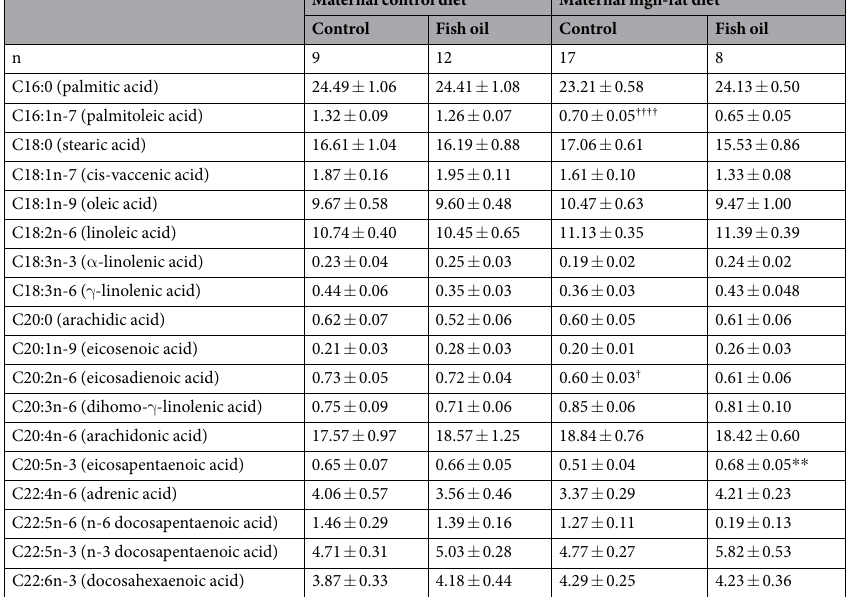
Table 6. Concentrations of polyunsaturated fatty acids in liver phospholipids of rat pups culled at day 2, according to the maternal diet (control or high-fat) and the gavage treatment during pregnancy [fish oil or control (water)]. Data are means ± standard errors. † p < 0.05 and †††† p < 0.0001 for a maternal diet effect among the offspring of dams that received control gavage; ** p < 0.01 for an effect of the gavage treatment between groups exposed to the same maternal